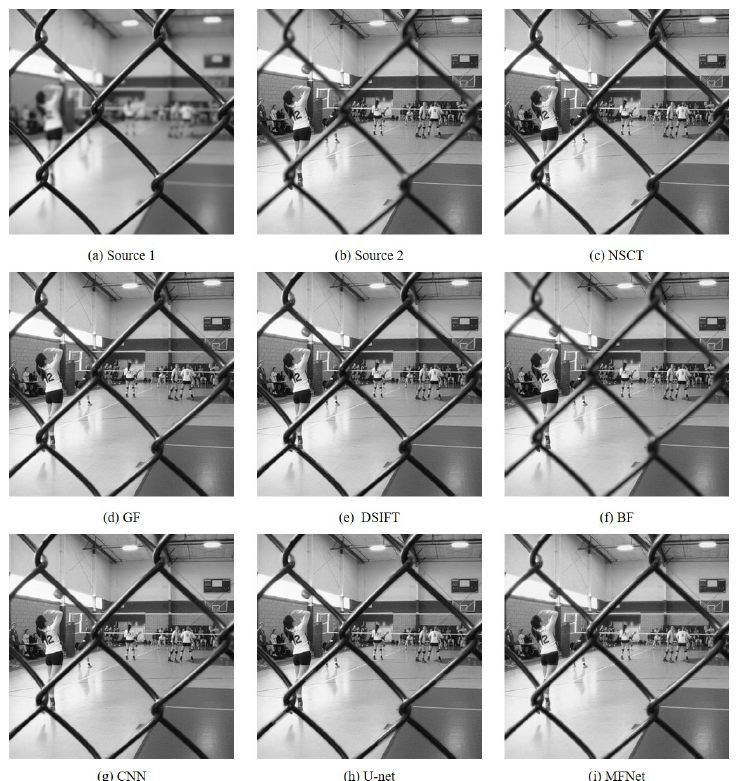
Figure 5. The “Volleyball Court” source image pair and their fused images obtained with different fusion methods.